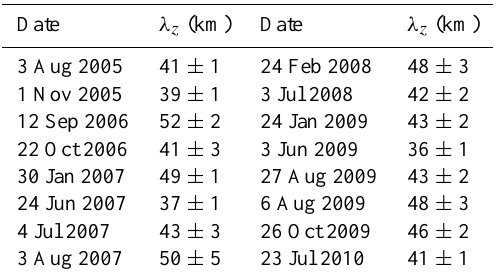
Fig. 12. Phase as a function of height for the single large-amplitude E1 UFKW event observed over a ten-day interval centred on 3 Au- gust 2005, obtained from Aura MLS observations. Phase has been arbitrarily set to zero in the top height gate. The best-fit straight line is indicated and corresponds to a vertical wavelength of 41 ± 1km. Table 1. Vertical wavelengths, λ z , for 16 large amplitude UFKW events in the Aura MLS data centred on the dates given. The mean vertical wavelength is 44 ± 2km.